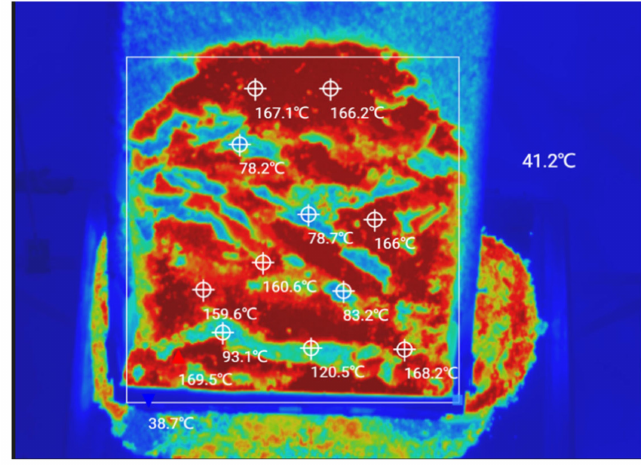
Figure 8. Infrared thermal image of the asphalt mix on the tipper truck.